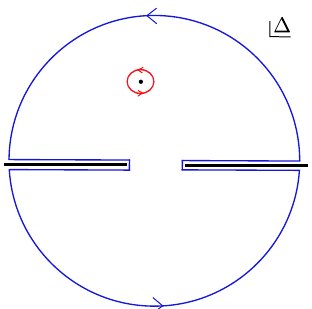
Figure 1 . Dispersion relations in (cid:1) plane. We consider the contour integral (3.22) and deform the contour in the usual